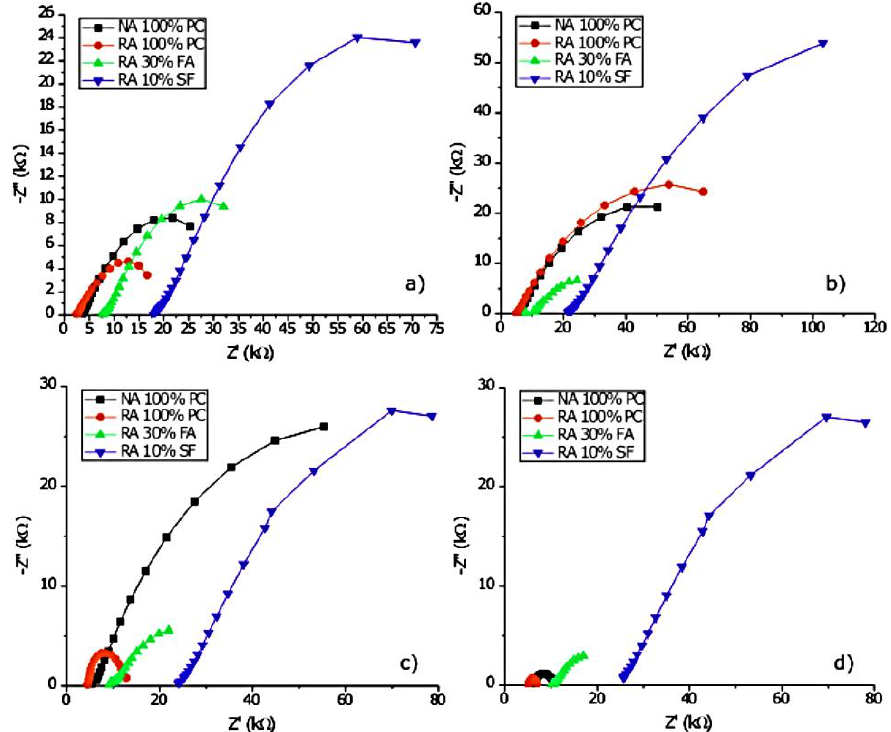
Figure 3. Effect of RAs, supplementary cementitious materials and time (REF): ( a ) 3 months, ( b ) 6 months, ( c ) 9 months, ( d ) 12 months. References: FA = fly ash; SF = silica fume, PC = Portland cement, NA = coarse natural aggregate; RA = coarse recycled aggregate. Reproduced with permission from Ref. [87]. 2011, ESG.